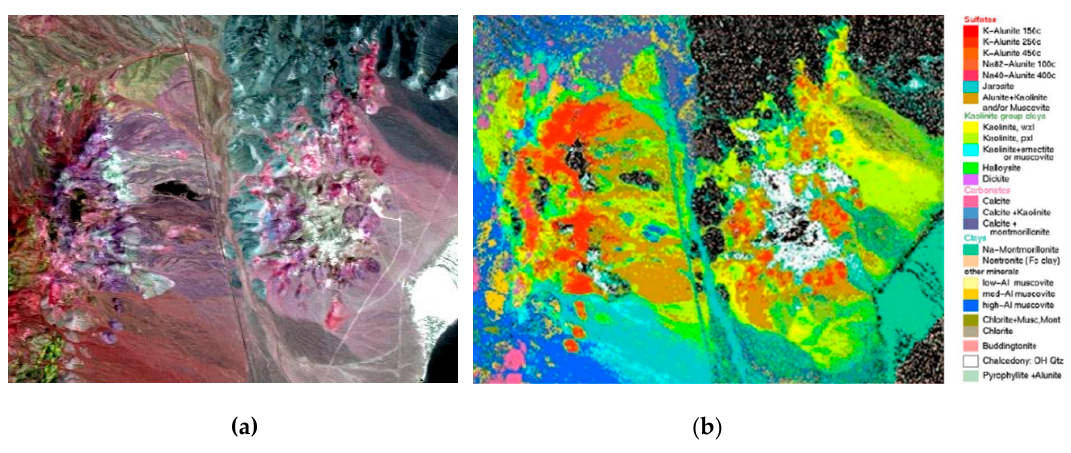
Figure 6. Dataset of the Cuprite mine in Nevada: ( a ) false color image and ( b ) ground truth map.